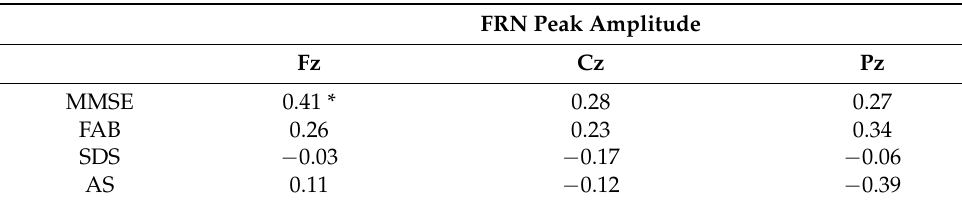
Figure 4. Correlations between the mini-mental state examination (MMSE) score and feedback-related negativity (FRN) amplitude. Table 2. Correlation coefficients between neuropsychological data and feedback-related negativity (FRN) amplitude.